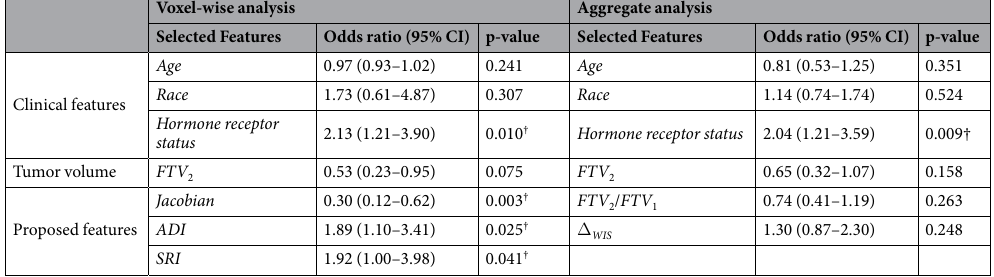
Table 2. Statistical analysis of voxel-wise versus aggregate features in multivariable pCR models. † p <